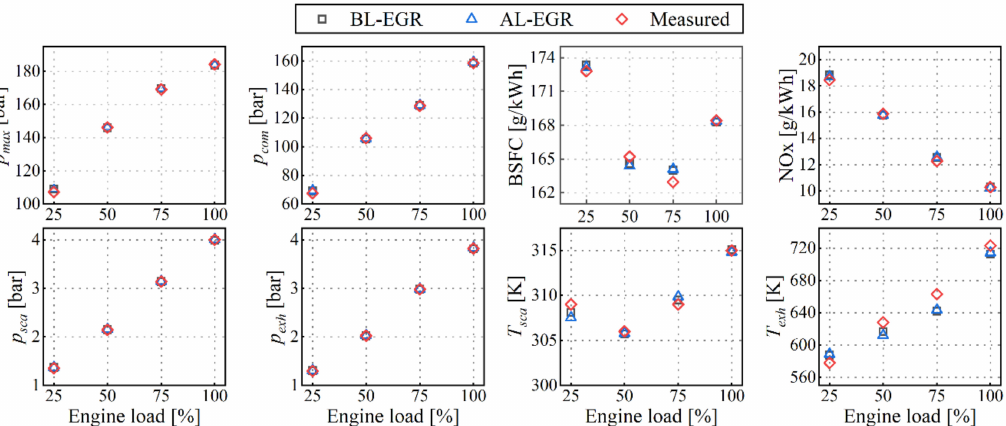
Figure 4. Comparison of predicted values against measured data for the BL-EGR and AL-EGR engine configurations at the Tier II mode.